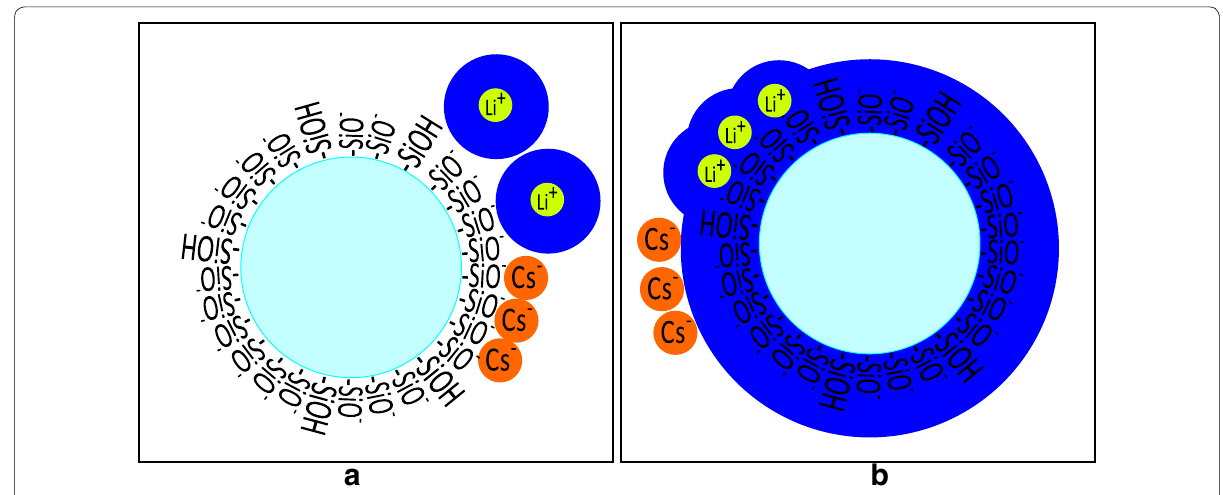
Fig. 4 a The Hofmeister theory where silica is a structure breaker surface and do not have a ordered hydration layer which allows structure breaker ions to adsorb closer than structure maker ions. b The theory suggested by [37] where the silica surface is a structure maker surface and thus has a ordered hydration layer which allows structure maker ions to adsorb more closely to the